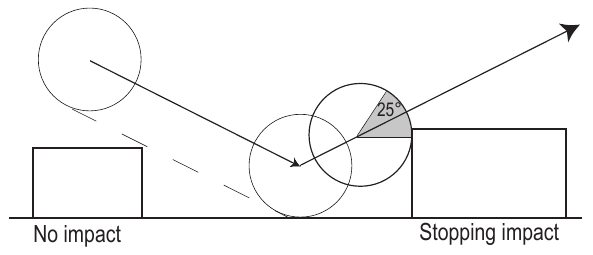
Fig. 7. 2-D-scheme for calculating the stopping probability of a rock (indicated by circles) during a single ground contact. The gray arc indicates the sensitive 25 ◦ region for considering a collision as a stop.